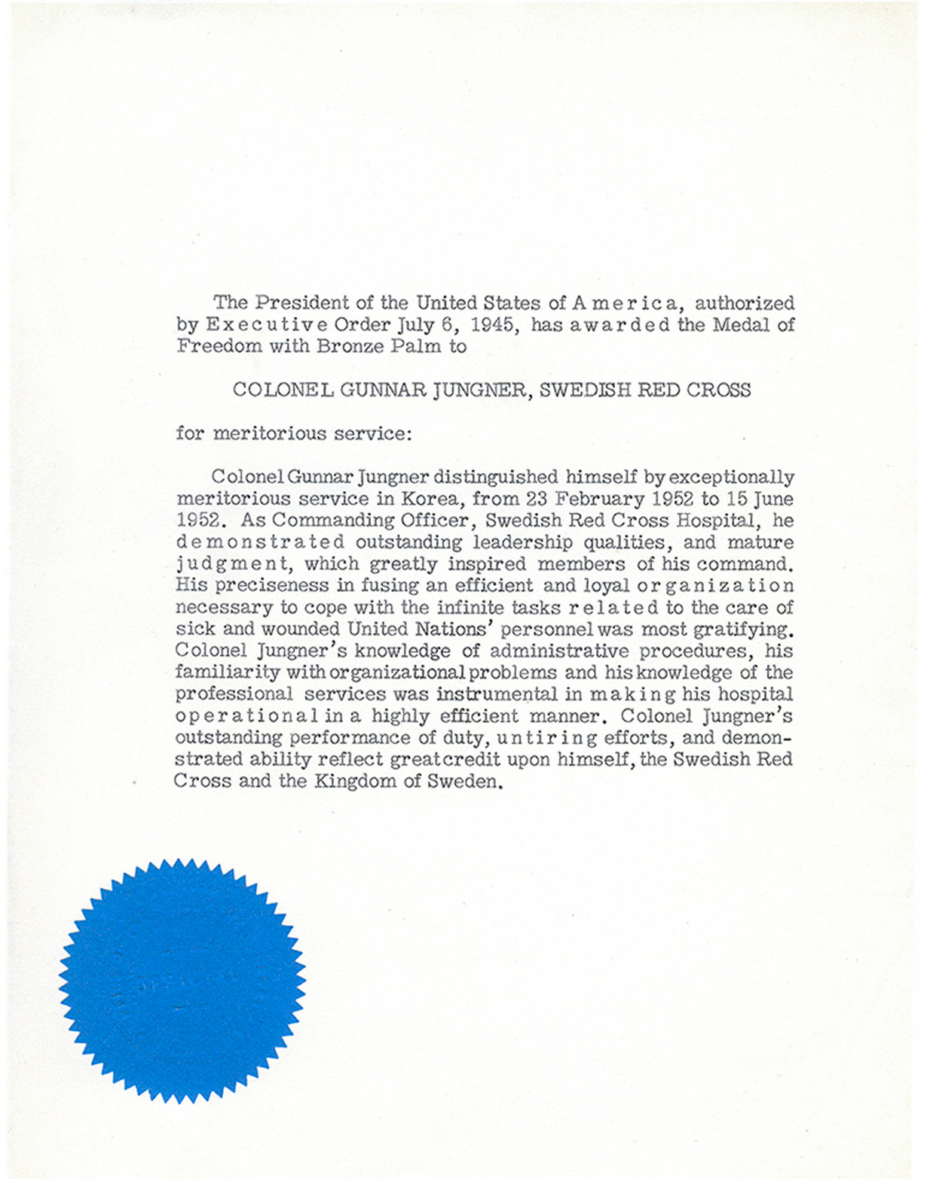
Figure 4. Announcement 6 July 1945, that Colonel Gunnar Jungner, Swedish Red Cross, has been awarded the Medal of Freedom with Bronze Palm by the President of the United States of America for meritorious